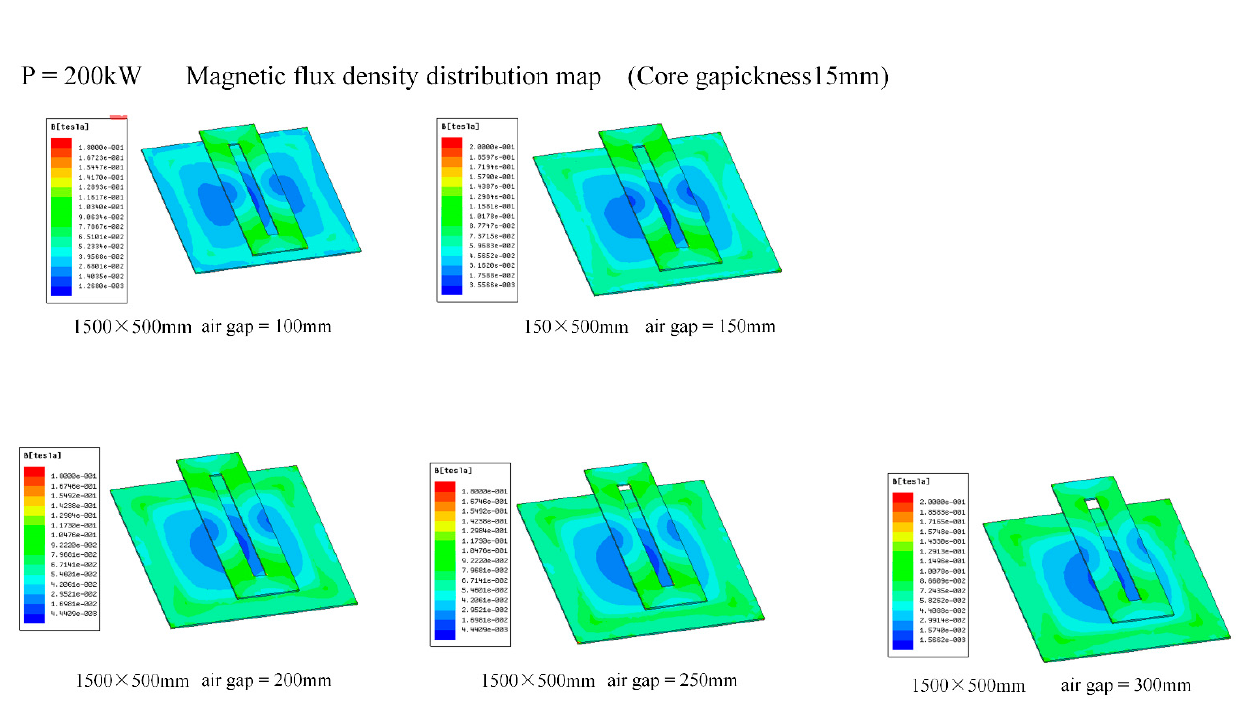
Figure A1. Magnetic field simulation diagram.